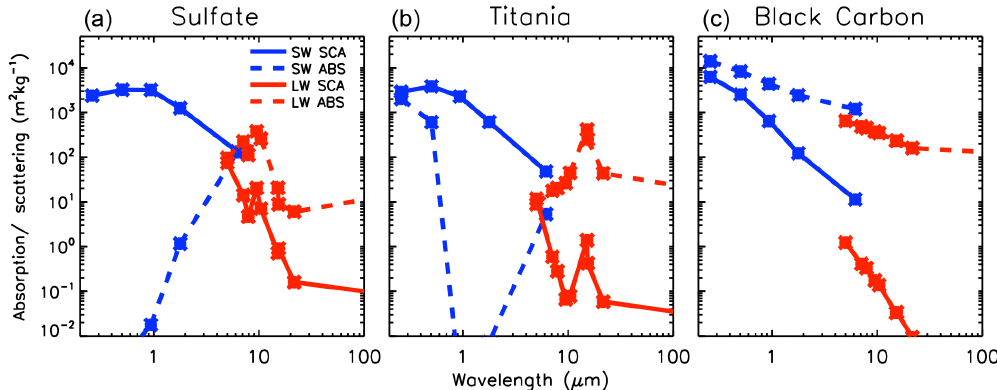
Figure 1. Optical properties as a function of wavelength for (a) accumulation-mode sulfate, (b) titania, (c) black carbon. Points are plotted at the middle of each spectral waveband, as detailed in Bellouin et al.